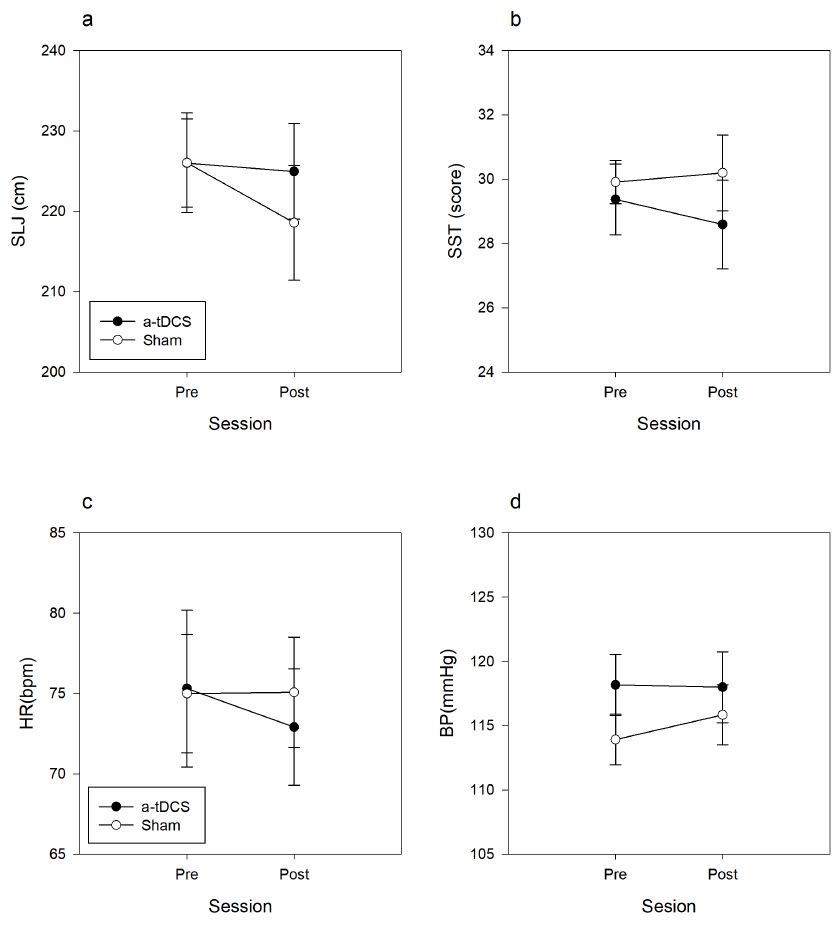
Fig. 4. Physical performance, heart rate, and blood pressure measures. Changes in physical performance, HR, and BP measures from pre-tDCS session to post-tDCS session in the (a) standing long jump, (b) sidestep test, (c) heart rate, and (d) blood pressure. Error bar represents standard